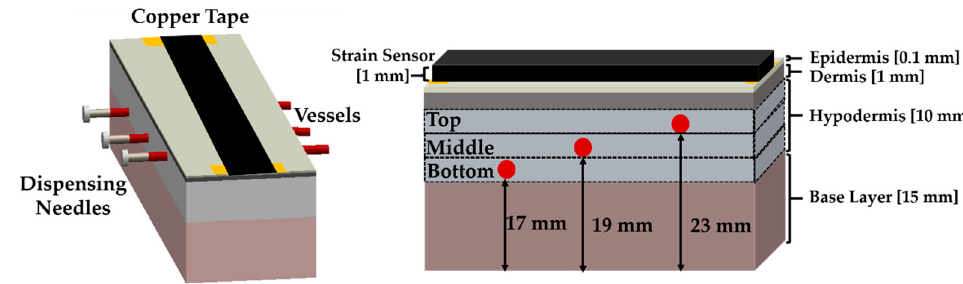
Figure 3. Structure of the simple flow phantom. Table 2. Composition of the flow phantom.